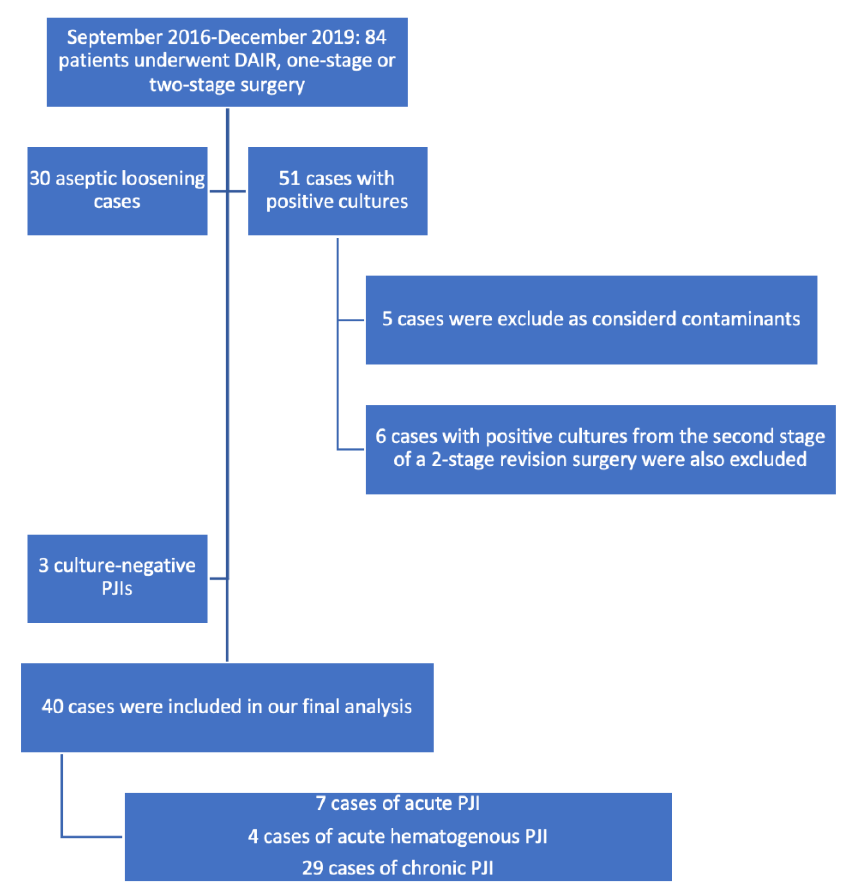
Figure 1. Flow diagram showing details of the enrolled patients.